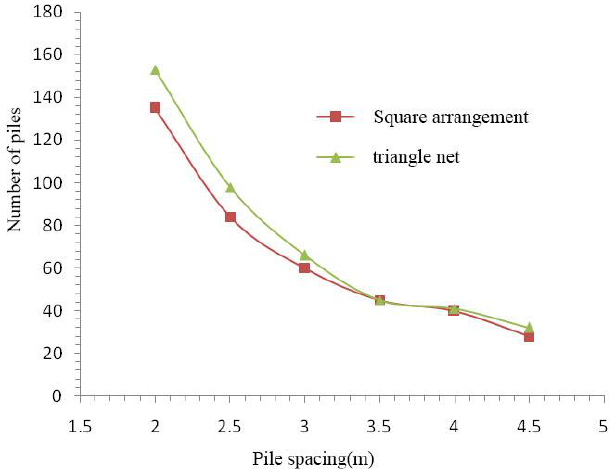
Figure 17. Differential settlement of pile soil with square and triangle net arrangements of piles and different pile spacings.